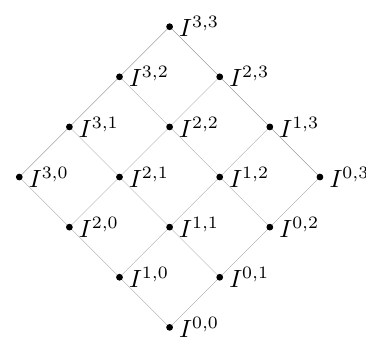
Figure 1. Arrangement of the Deligne splitting I p,q for Calabi-Yau threefolds.